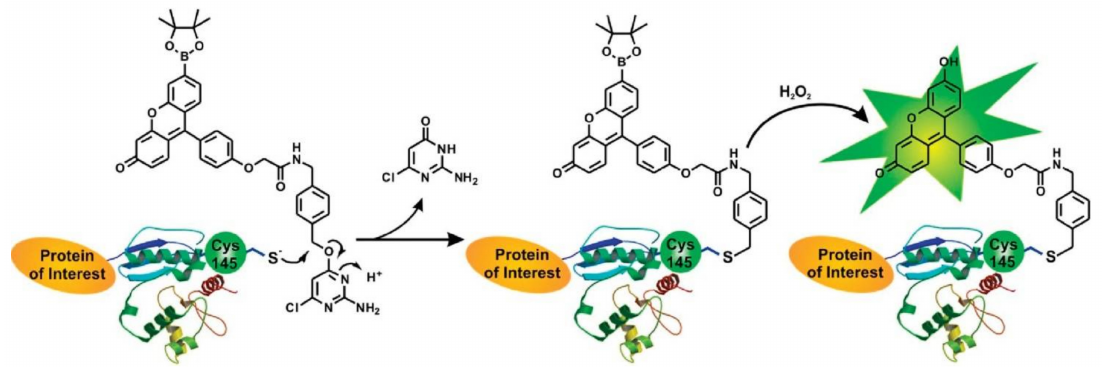
Figure 50. Design strategy for organelle-specific hydrogen peroxide reporters using the SNAP-tag methodology. Reprinted with permission from [164]. Copyright 2010, American Chemical